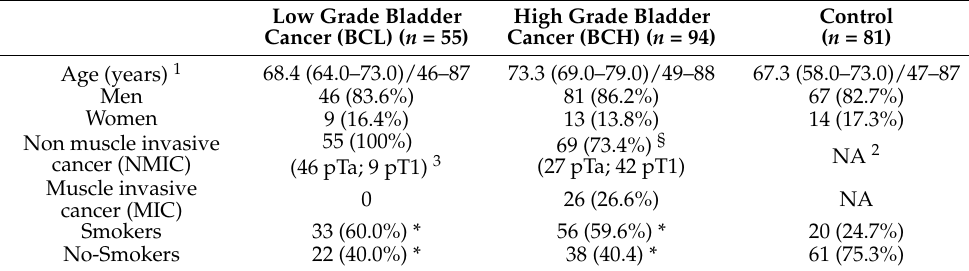
Table 1. Enrolled subject